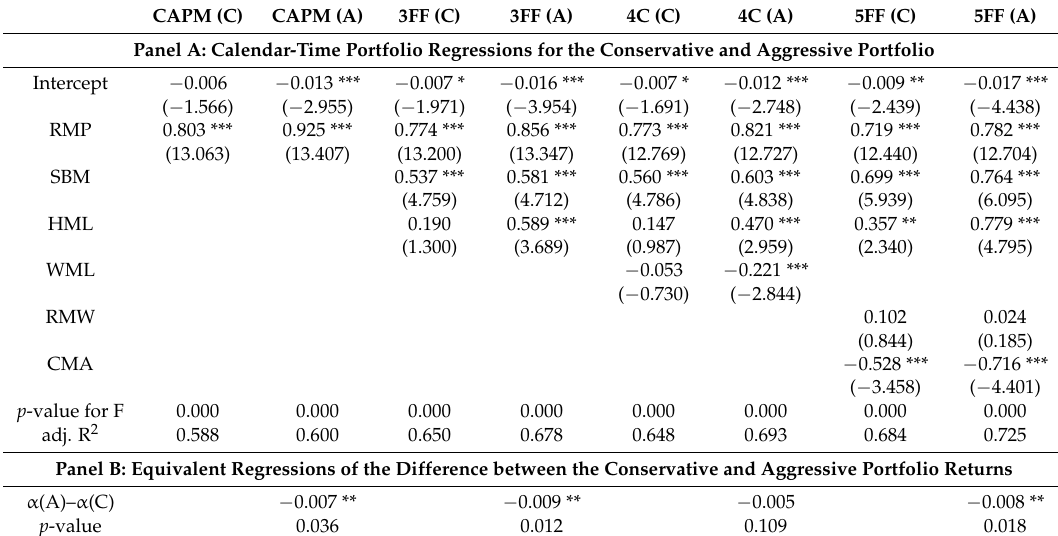
Table 2. Calendar-time portfolio regressions according to the Jones model.